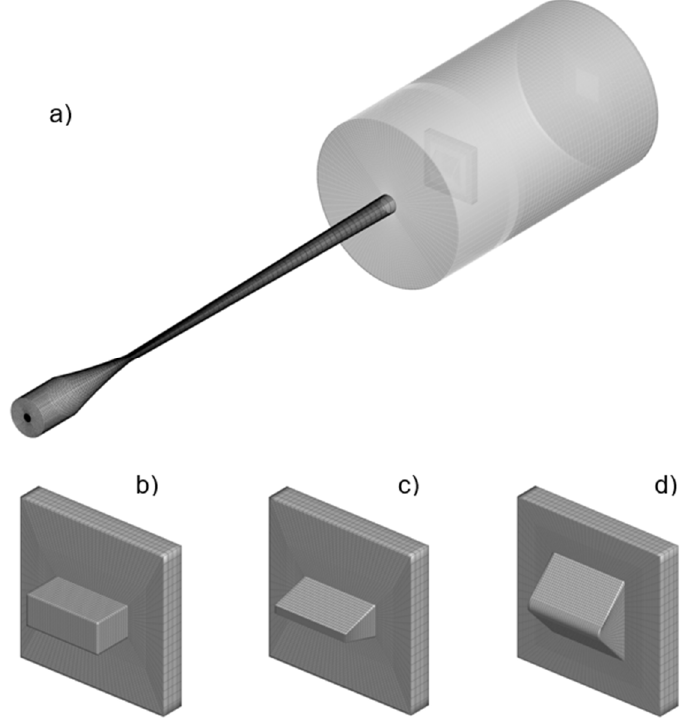
Figure 2. ( a ) Computational domain, ( b ) Mesh for vertical wall with a uniform cross-section, ( c ) Mesh for Inclined wall with non-uniform cross-section, and ( d ) Mesh for smooth wall.